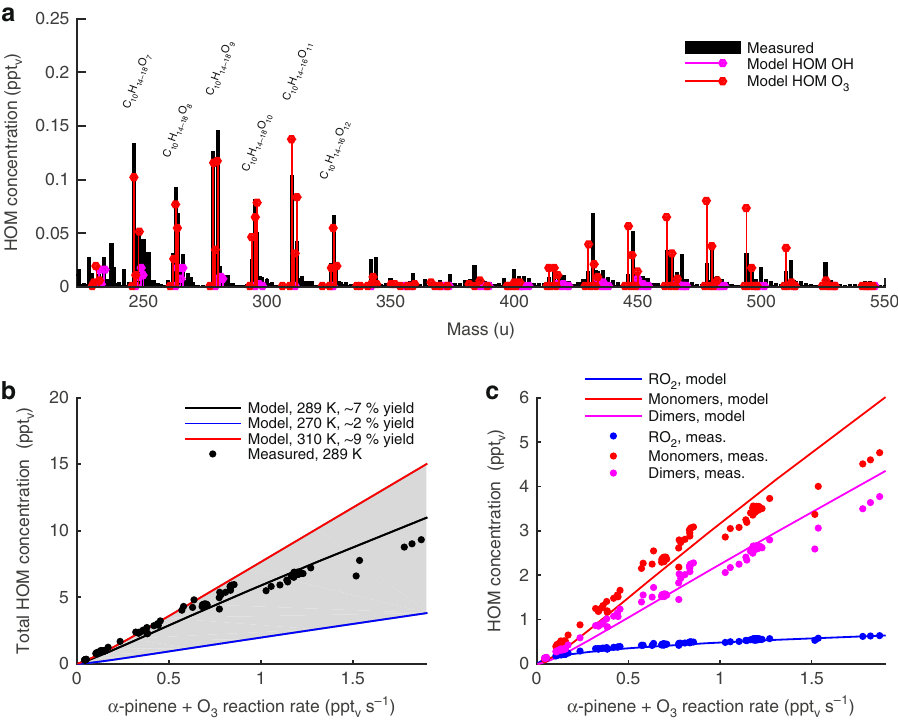
Fig. 1 Highly oxygenated organic molecule (HOM) formation from α -pinene. Modelled and measured HOM(g) concentrations during a JPAC α -pinene ozonolysis experiment 9 . Panel a shows the modelled and measured HOM mass spectrum at an α -pinene + O 3 reaction rate of ∼ 0.3 ppt v s − 1 . Panel b modelled and measured total HOM concentration at various α -pinene + O 3 reaction rates. c Concentrations of HOM peroxy radicals (RO 2 ) and HOM closed shell monomers and dimers. In panel a the modelled HOM mass spectrum is shown separately for HOM species formed via ozonolysis of α -pinene and via OH oxidation of α -pinene. The mass of the reagent nitrate ion is not included in the measured molecular masses. The shaded area in b illustrates the variation of the modelled total HOM yield in the temperature range from 270 K to 310 K. The HOM were measured with a nitrate-ion-based chemical ionization atmospheric pressure-interface time-of- fl ight mass spectrometer (CI-APi-TOF) (see